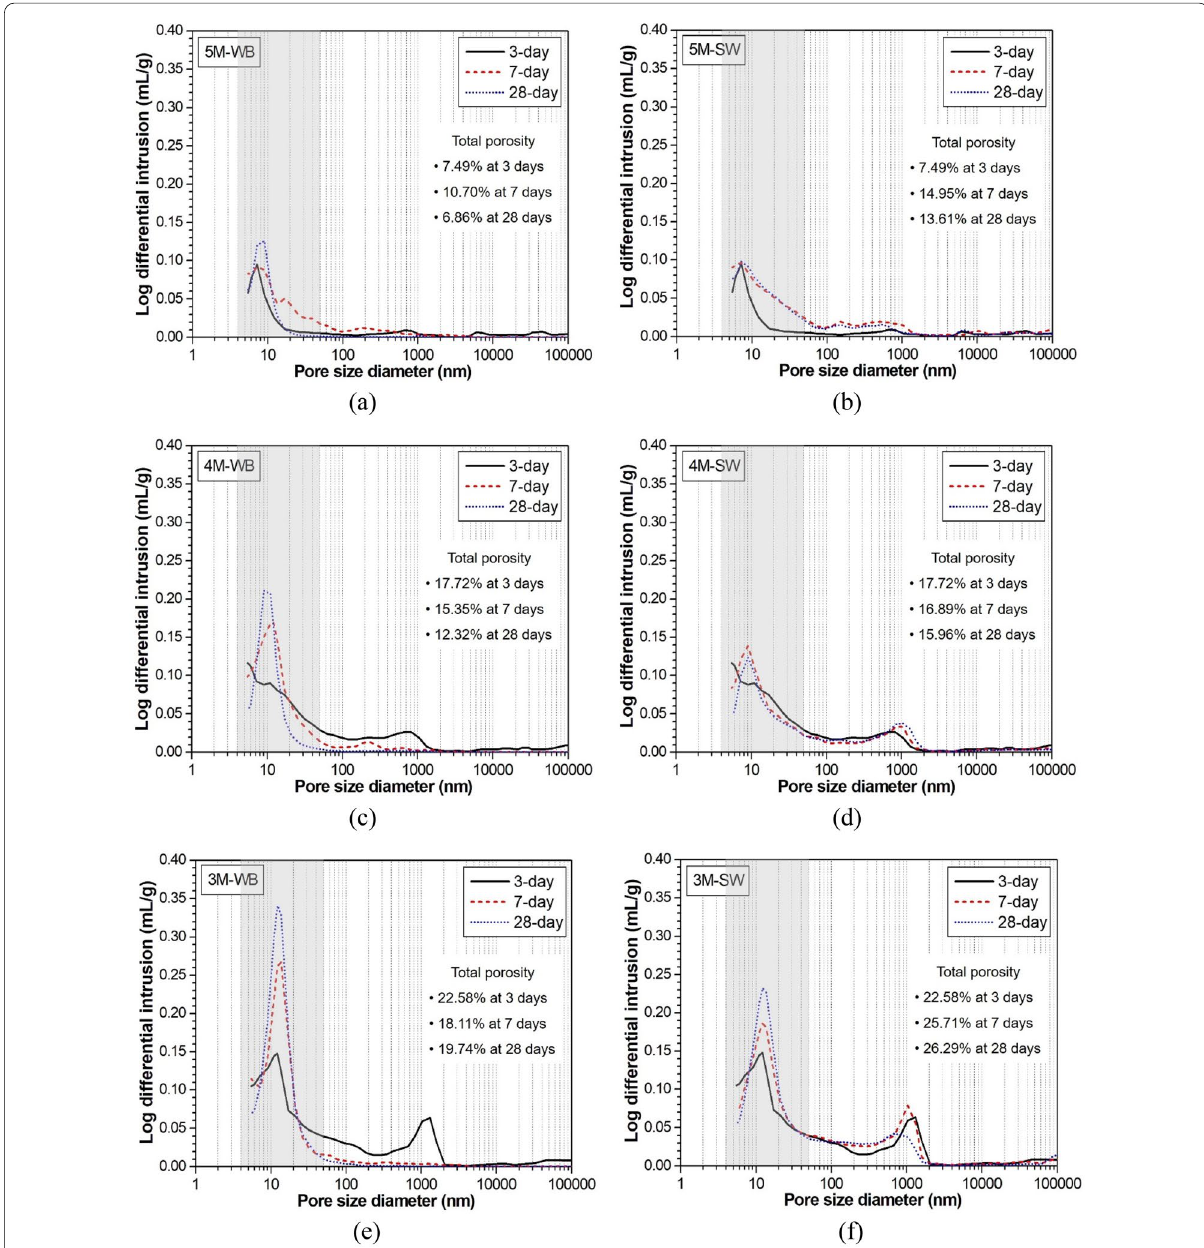
Fig. 6 Pore size distributions of ( a ) 5M-WB, ( b ) 5M-SW, ( c ) 4M-WB, ( d ) 4M-SW, ( e ) 3M-WB, and ( f ) 3M-SW samples. 3 days: when CO 2 curing was finished; 7 and 28 days: after subsequent curing in water bath (WB) or immersion in seawater